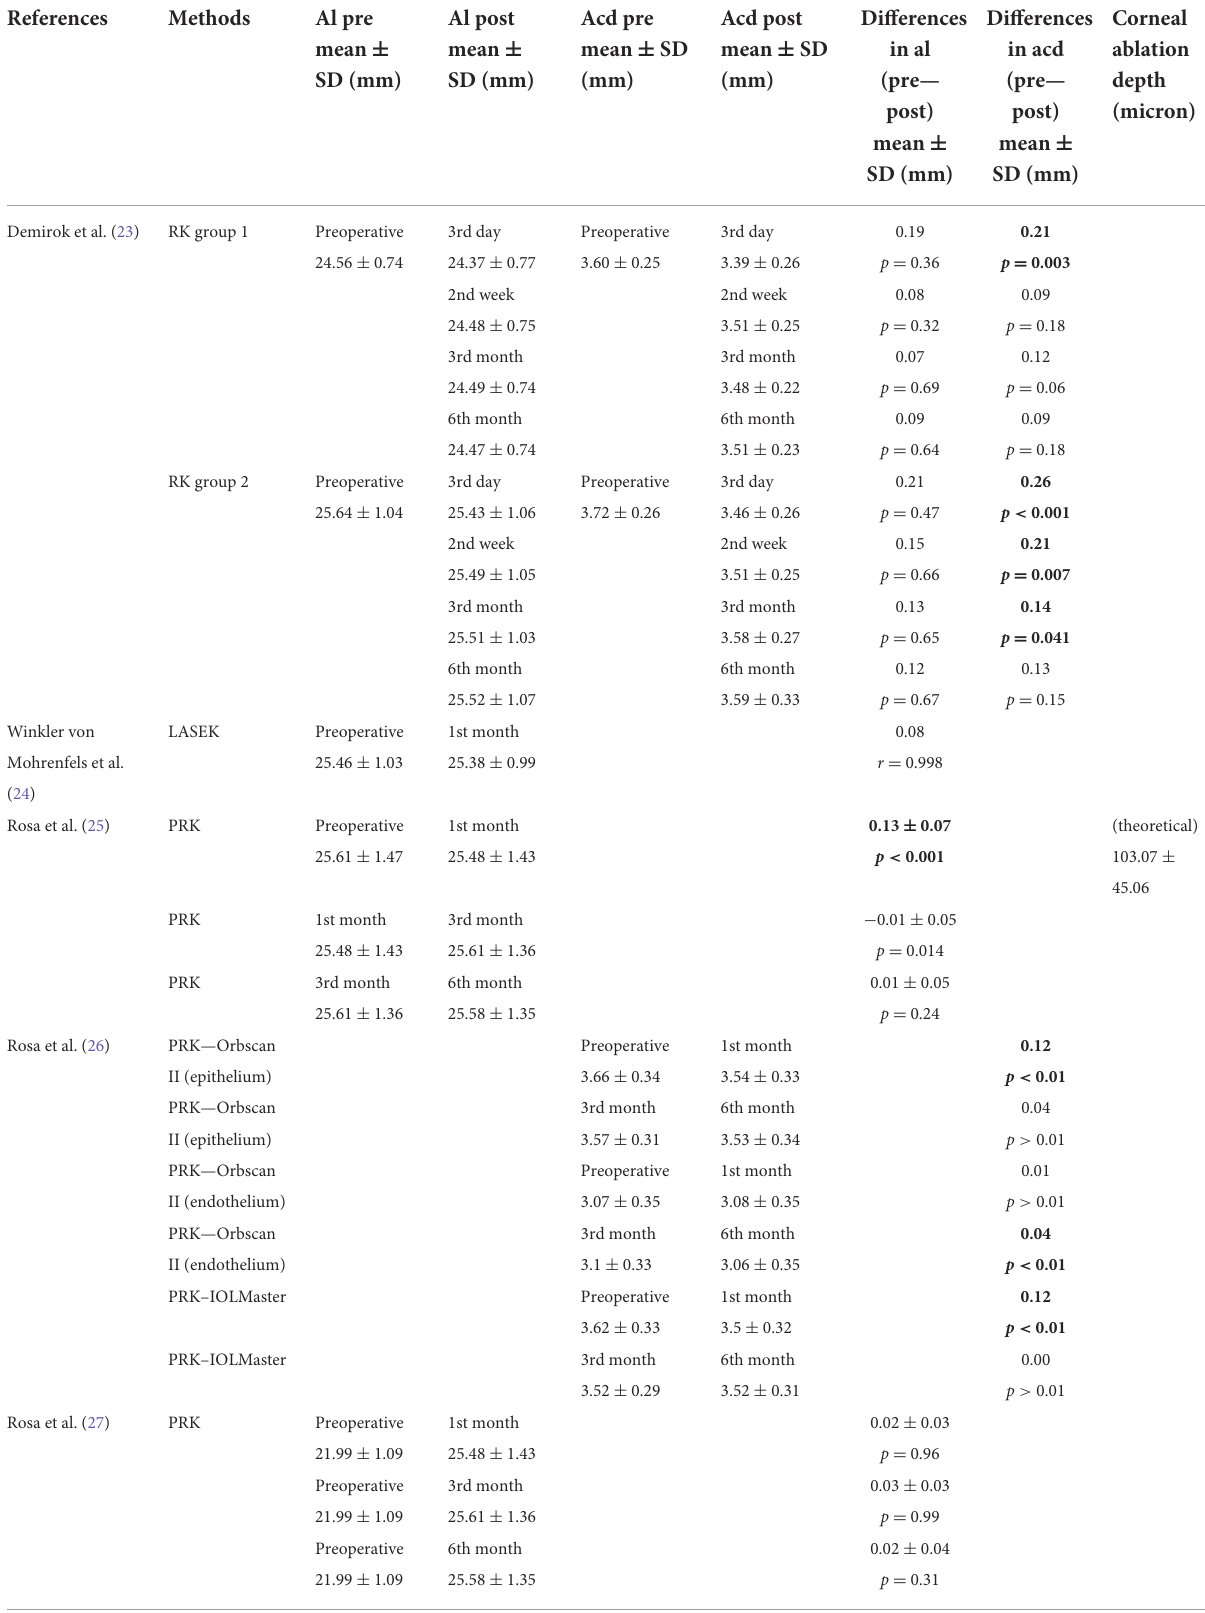
TABLE 1 Methods and results of the studies (significant values are in bold